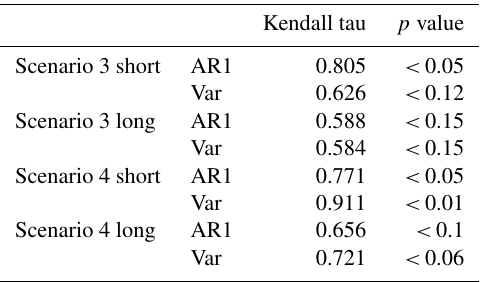
Table 3. Calculated significance statistics for two precursor metrics of tipping points. Kendall tau and p values are shown for autocor- relation (“AR1”) and variance (“Var”) trends over 250 (“short”) and 1500 (“long”) sliding windows, for two scenarios in which distinct inflections occur in their mass loss time series. See Fig. 10 for more